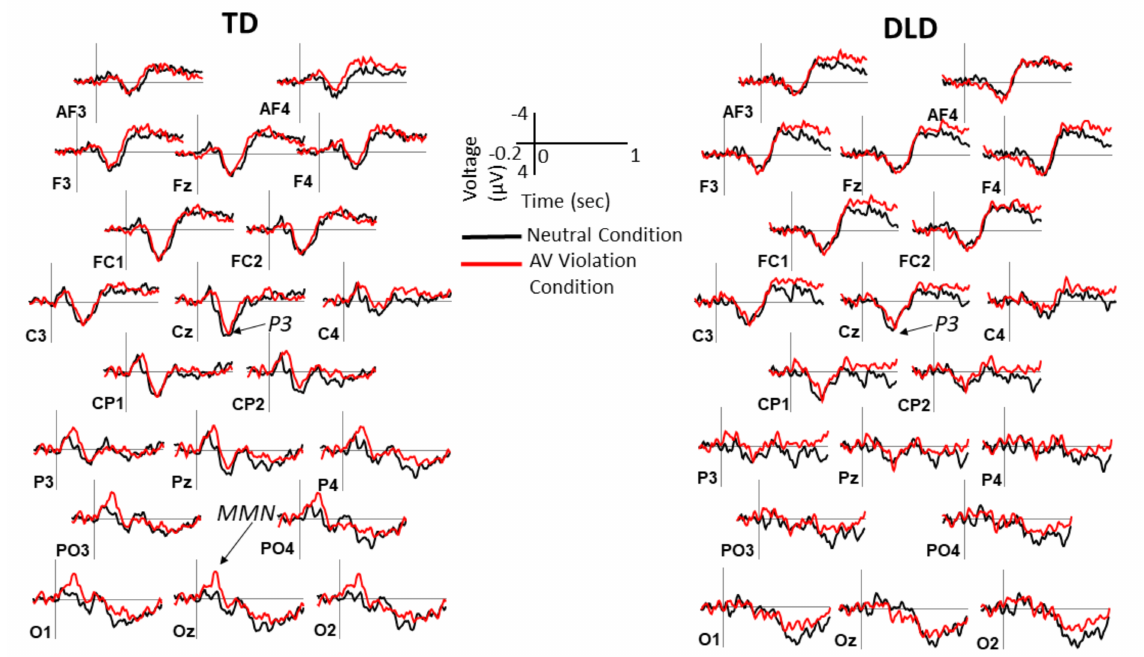
Figure 4. Deviant minus standard difference waveforms in neutral and audiovisual violation conditions in each group. Grand average ERPs for deviant minus standard differences are shown separately for children with TD and children with DLD. Note the prominent MMN component posteriorly in the audiovisual violation condition in children with TD and its absence in children with DLD. Negative is plotted up. The P3 component is marked on the Cz site and the MMN component on the Oz site (where present). Time 0 marks the onset of sound. AV =